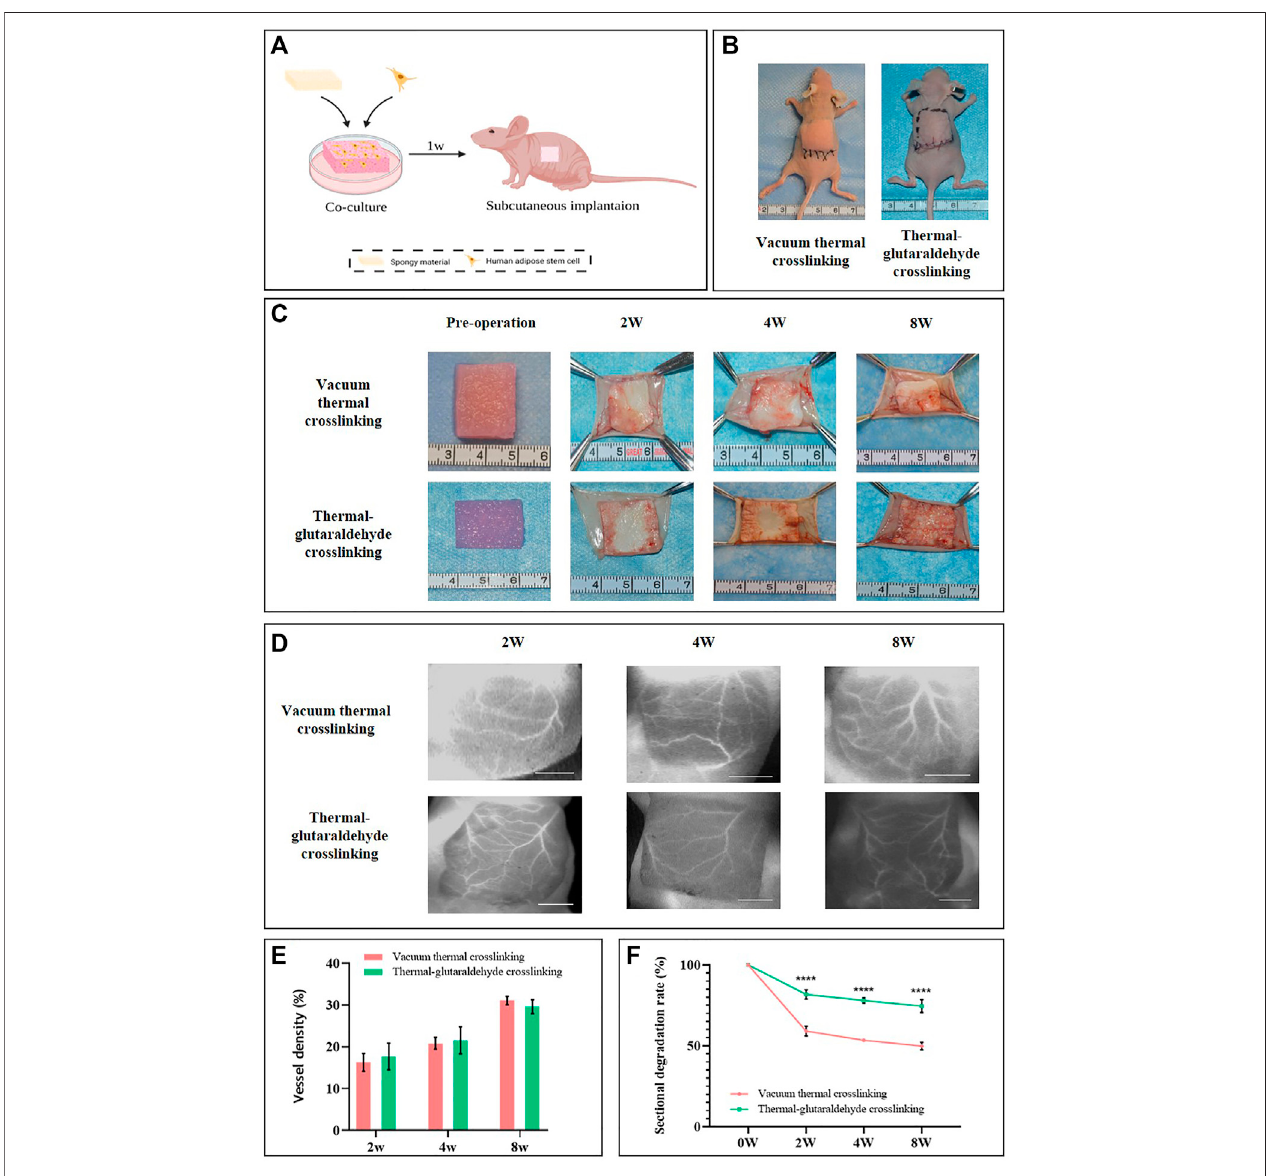
FIGURE 5 | In vivo experiments. (A) Schematic diagram of animal experiments was created by BioRender.com. (B) Intra-operative views after VT-ADM and GA- ADM implantation. (C) Gross views of the ADM sponges before operation and at observation ending timepoints. (D) ICG images of blood vessels on local skin fl ap anterior to VT-ADM and GA-ADM, bar = 5 mm. (E) Vessel density of local skin fl aps at 2w, 4w, and 8w was analyzed by the AngioTool ( n = 3 for each group). (F) Degradation rates of VT-ADM and GA-ADM at 2w, 4w, and 8w ( n = 3 for each group). *p < 0.05 , **p < 0.01 , ***p < 0.001 , and ****p < 0.0001.